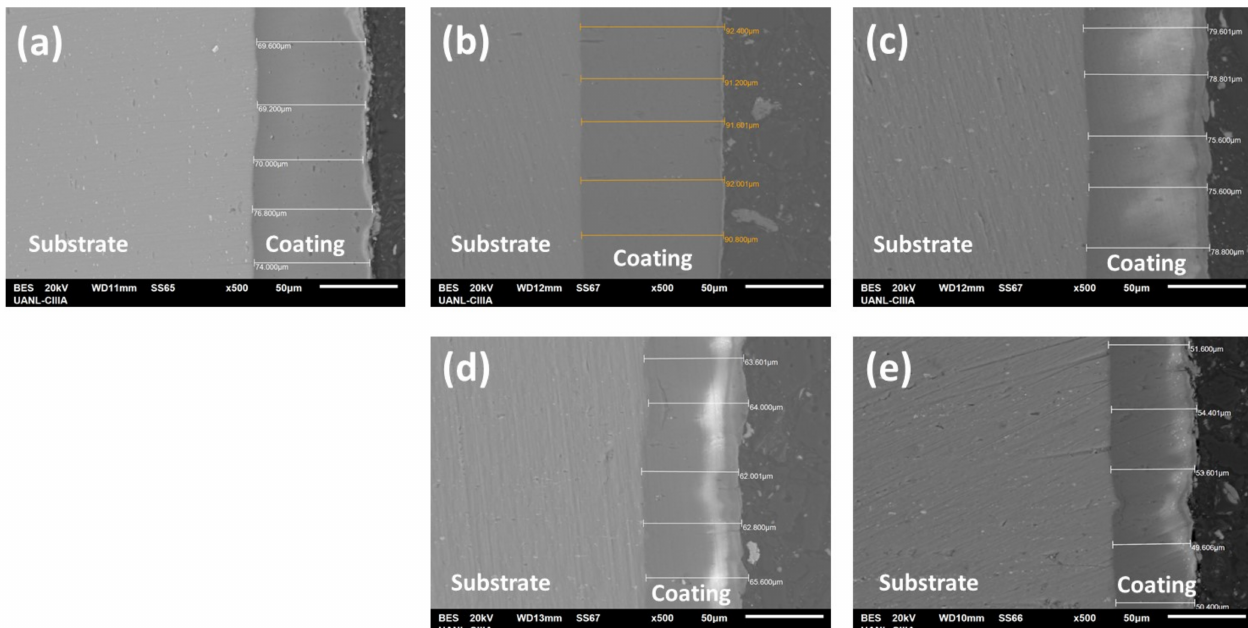
Figure 3. SEM Cross-Sectional Micrographs of the AA6061 Anodized a 3 A/dm 2 in Different Bath: ( a ) 3A C0M S2M, ( b ) 3A